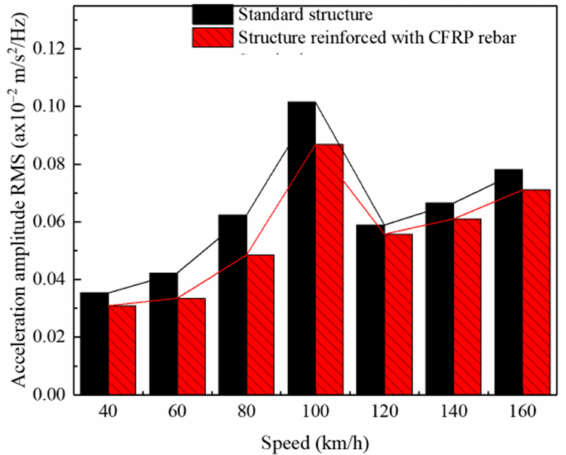
Figure 20. Acceleration amplitude RMS diagram at point A.